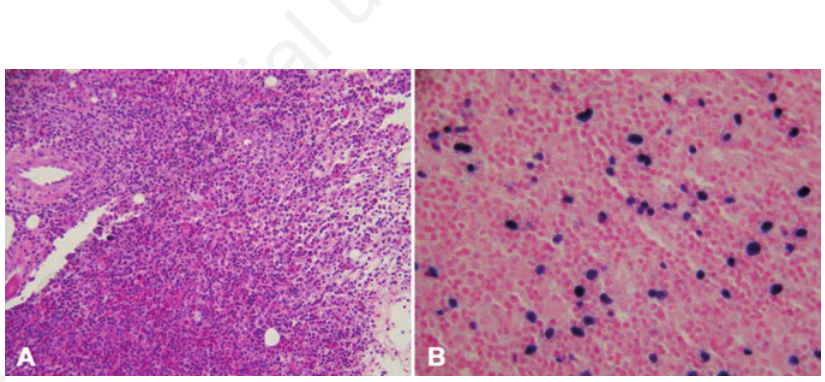
Figure 1. Bone marrow biopsy revealing hypercellular marrow with atypical lymphoid infiltrates (A) and left axillary lymph node biopsy with numerous lymphocytes staining positive for Epstein-Barr virus (B).